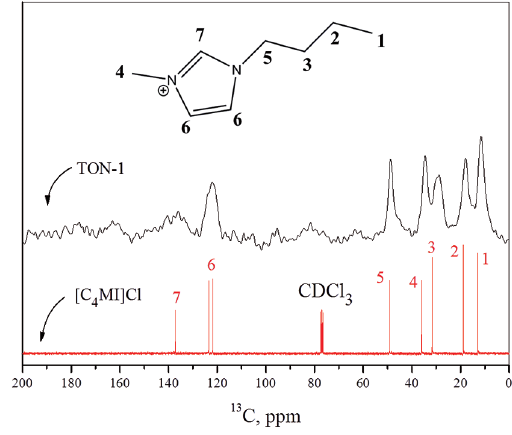
Figure 5: 13 C CP MAS NMR of as-prepared ionic liquid (bottom) and within the TON zeolite (top).